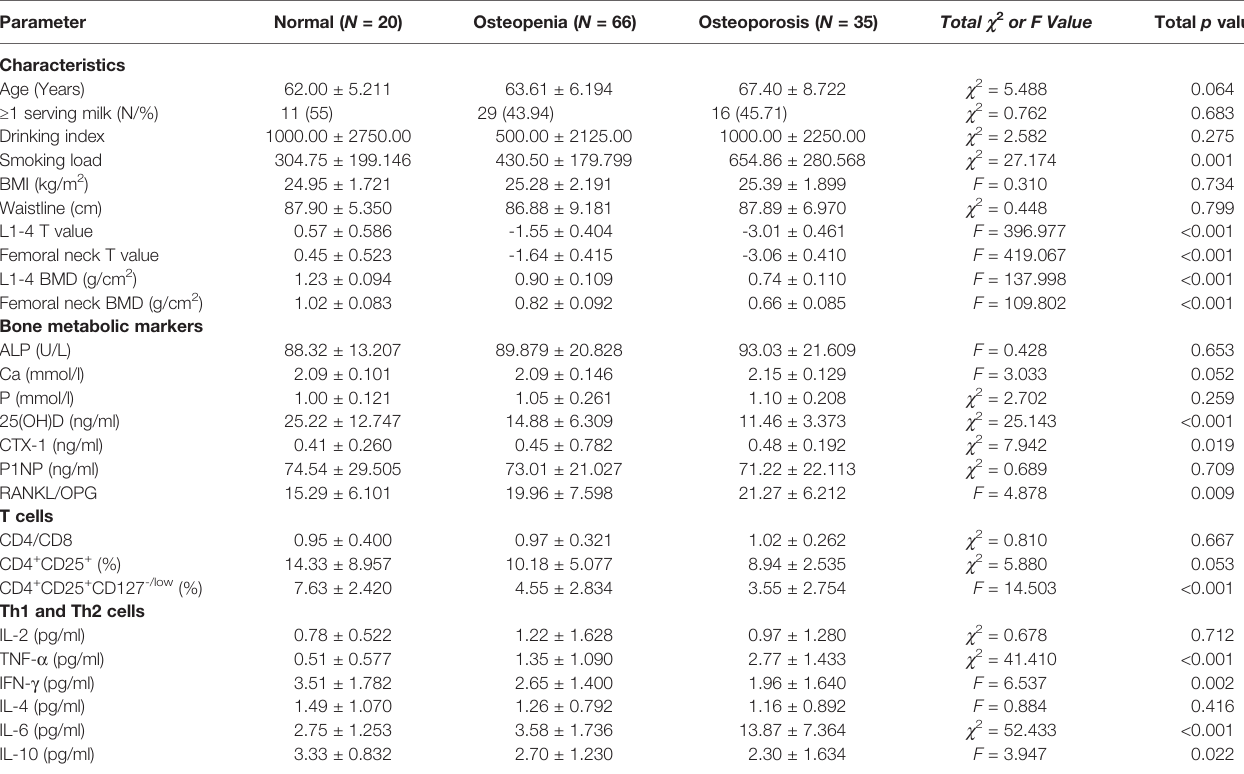
TABLE 1 | Clinical parameters and laboratory indicators of the studied groups in males.